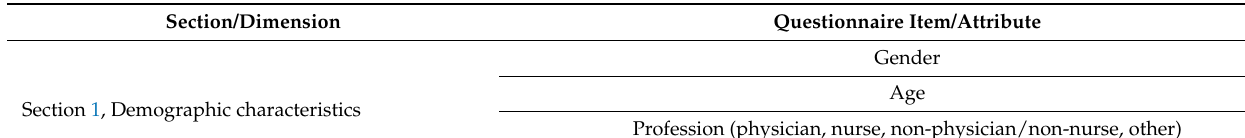
Table 1. Dimensions and items studied through the